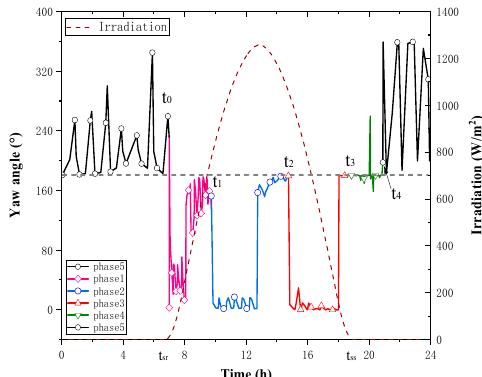
Figure 9. Optimal yaw angle profile with minimal battery mass.